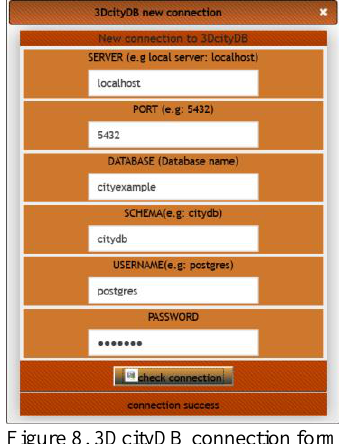
Figure 8. 3DcityDB connection